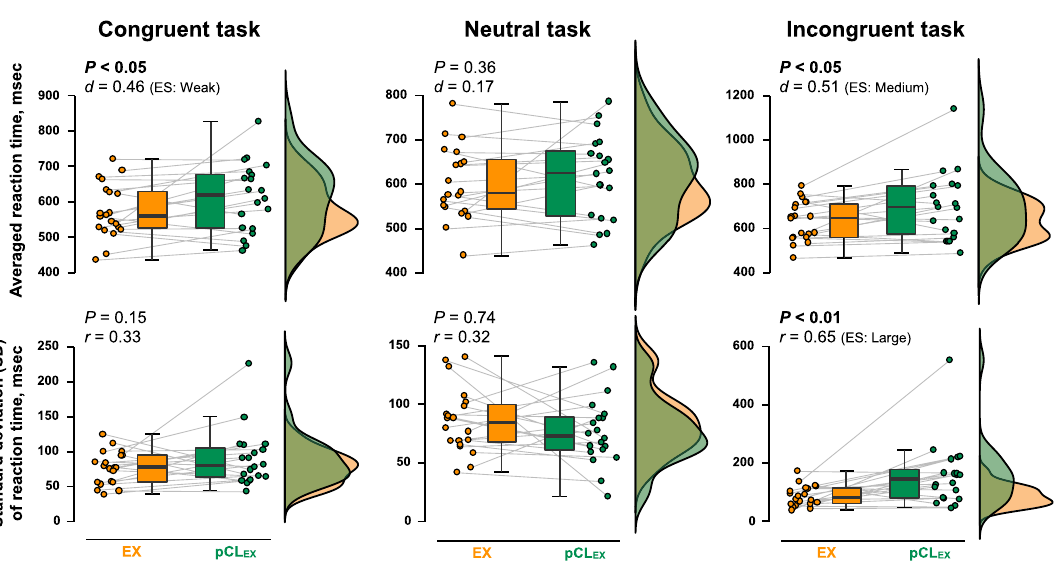
Figure 4. RT of CWST during the last 5 min of EX (orange) and pCL EX (green) conditions. Raincloud plots showing the distribution of RT data. Circle plots represent individual data, and box-and-whisker plots are median (IQR and max/min). The left side illustrations are the averaged data during 5-min collection, while the lower illustrations are the SD during 5-min data